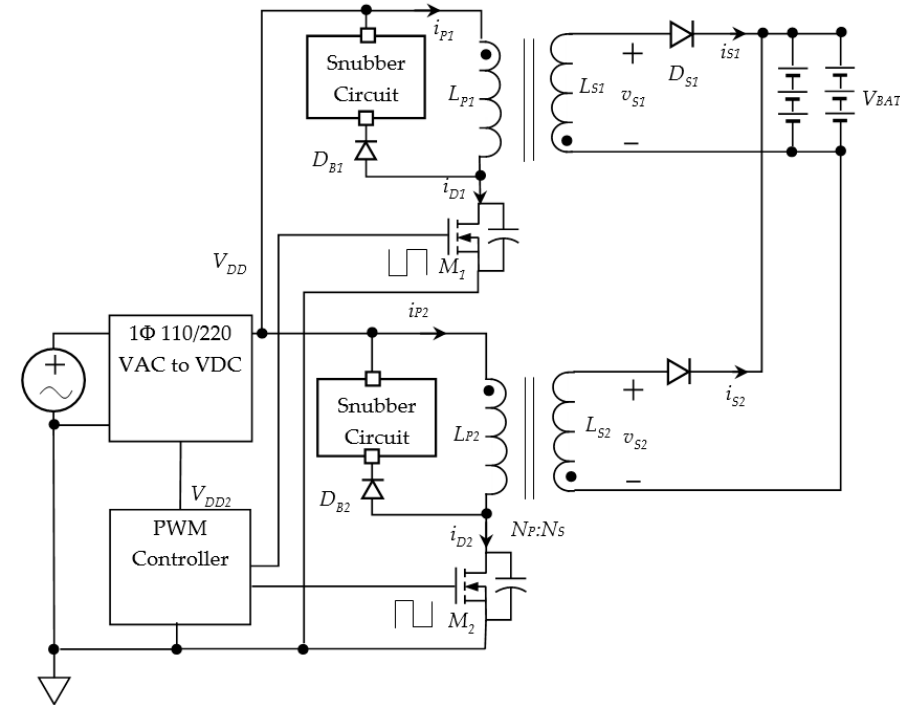
Figure 1. Interleaved flyback converter.